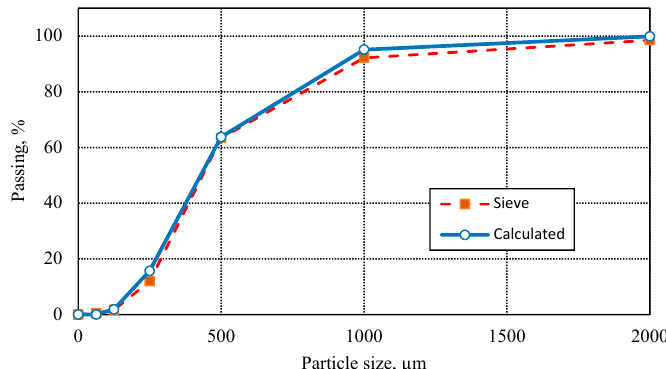
Figure 4. Comparison of the results from calculations and sieve analysis of sand.